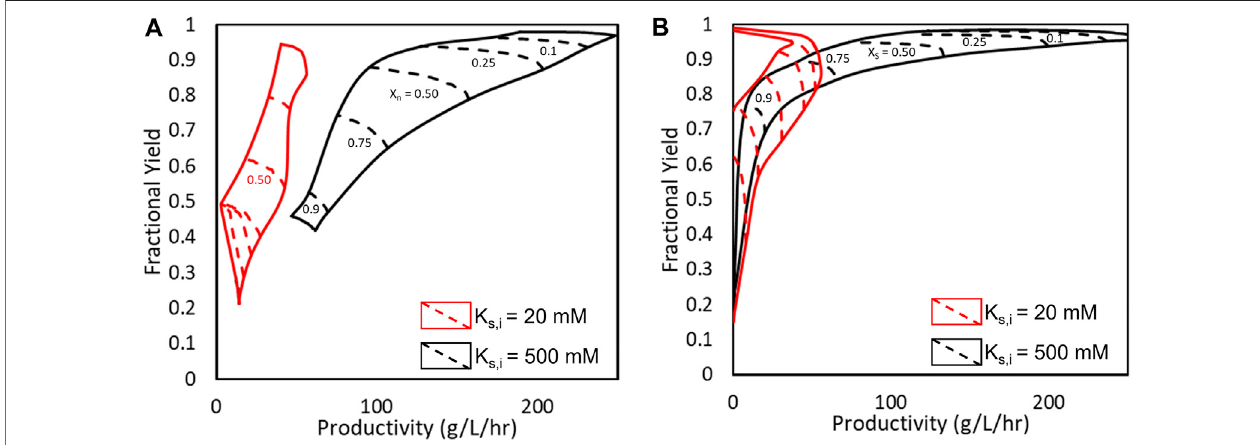
FIGURE 9 | Pareto optimal fronts for fractional yield and productivity under (A) varying 7-ADCA conversion ( X 7-ADCA ) and (B) varying PGME conversion. The red curvesshowtheobtainablefractionalyields,productivities, andconversionsforthecurrentAEH( K S,I =20 mM)whiletheblackcurvesrepresentanengineeredAEHwith minimized substrate inhibition ( K S,I = 500 mM).